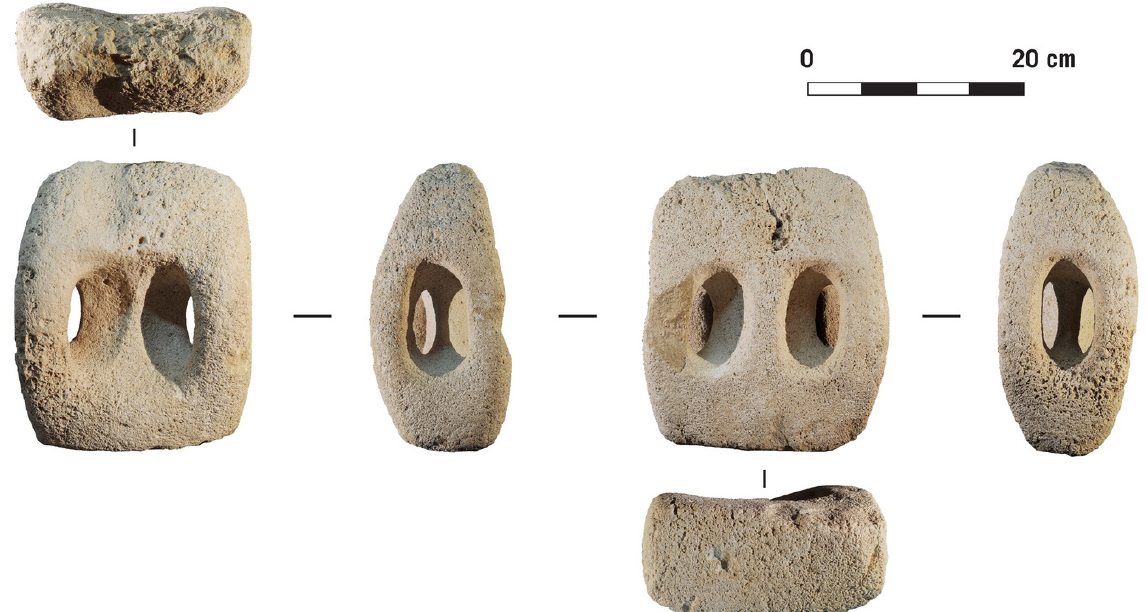
Figure 1. Lithic double-handled artefact ID 9120 used to deliver strong blows, observed in six different views. The tool was held by two opposing people and probably had a remarkable power of